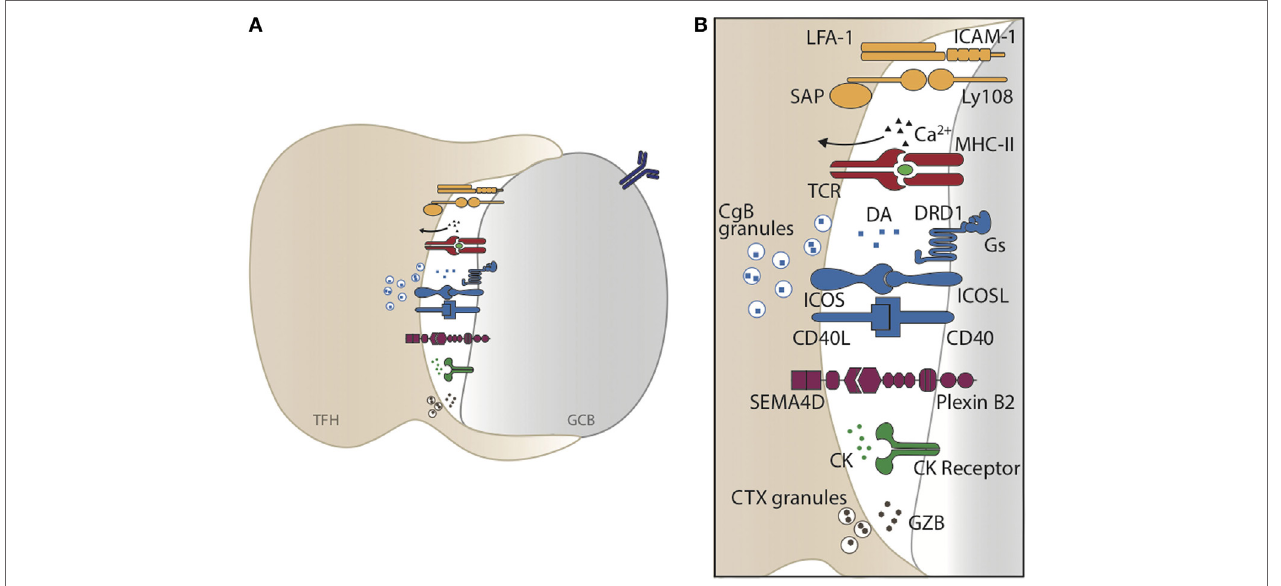
FiGURe 2 | T FH –germinal center (GC) B cell synaptic interaction. (A) Graphical representation of T FH and GC B cell interaction. Formation of optimal T FH –GC B cell synapses depends on specific interactions between receptor:ligand pairs and integrins, leading to a specific and focused transmission of cytokines, neurotransmitters, and cytotoxic granules. (B) Enlarged representation of the synaptic cleft forming upon T FH –GC B cell